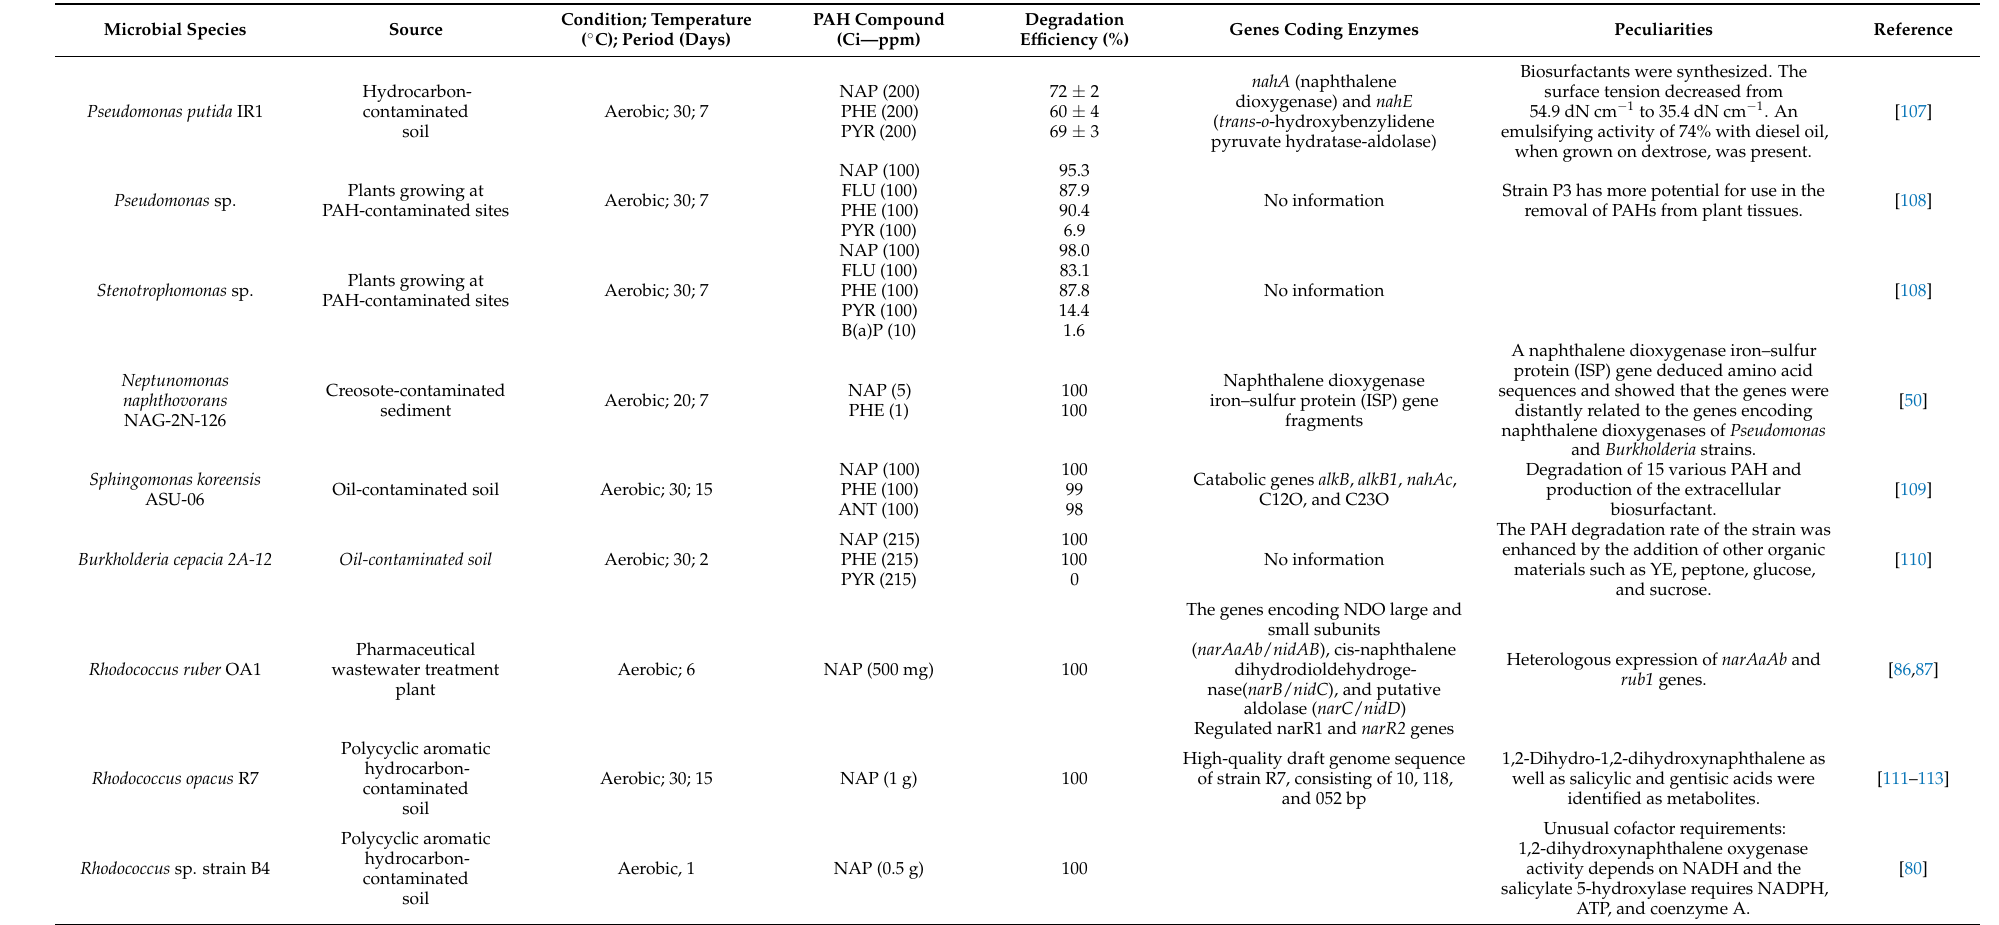
Table 1. Characteristics of the microbial process for naphthalene